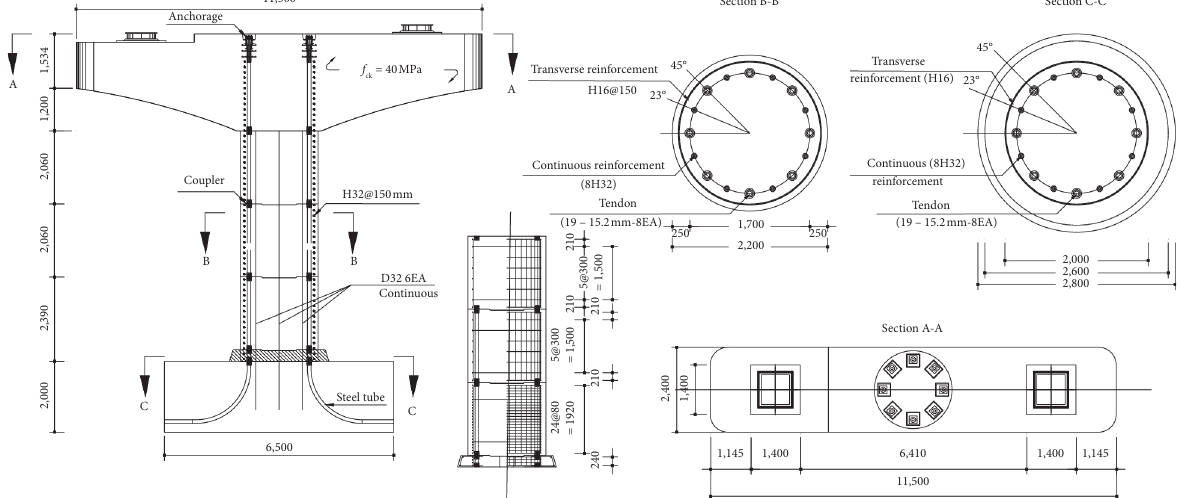
Figure 14: Detail of an example bridge pier.